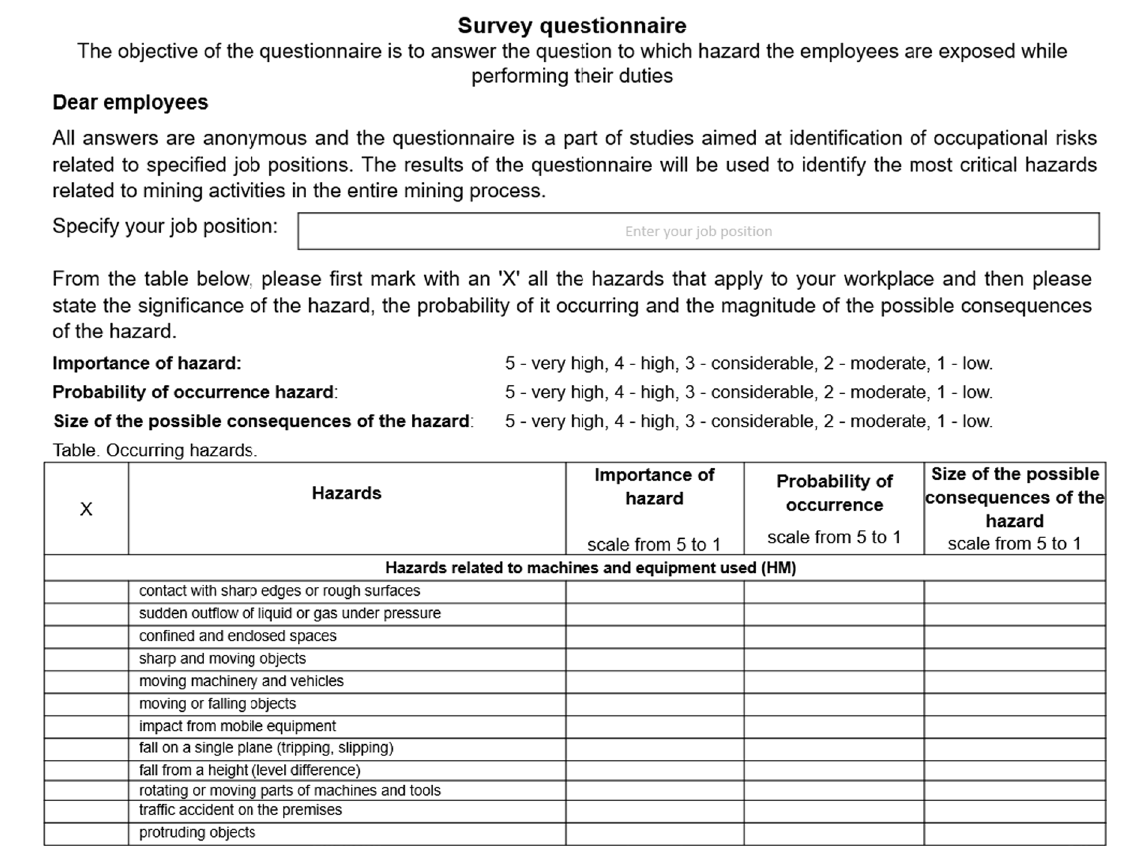
Fig. 2 Fragment of the employee survey questionnaire